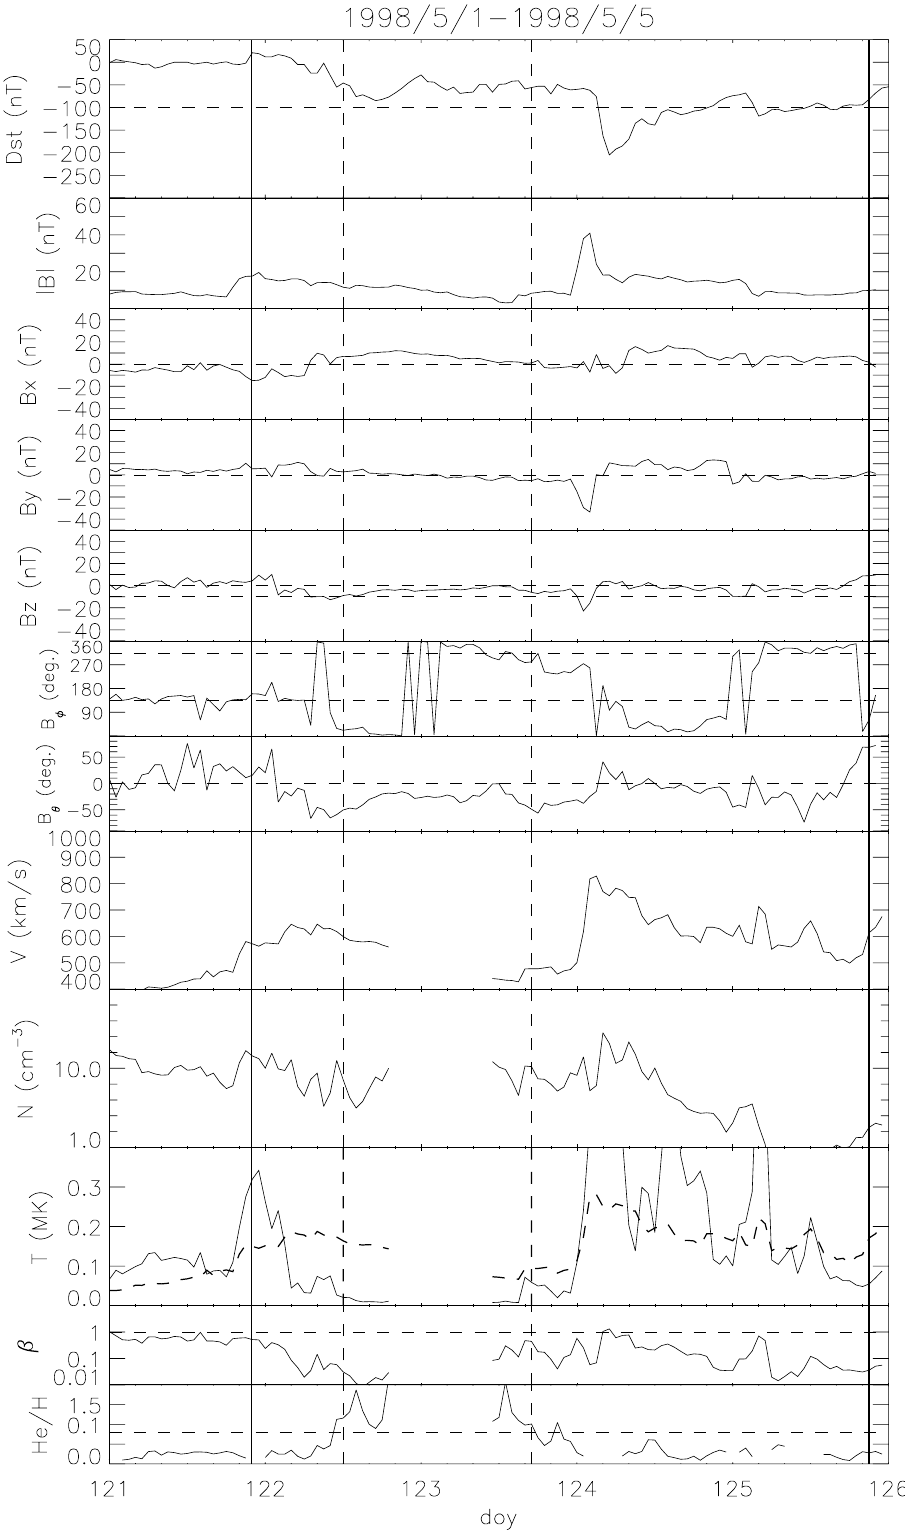
Fig. 5. D st index and solar wind parameters of storm no. 3. Two vertical solid lines show the duration of the geomagnetic storm and two vertical dash lines show the duration of a magnetic flux